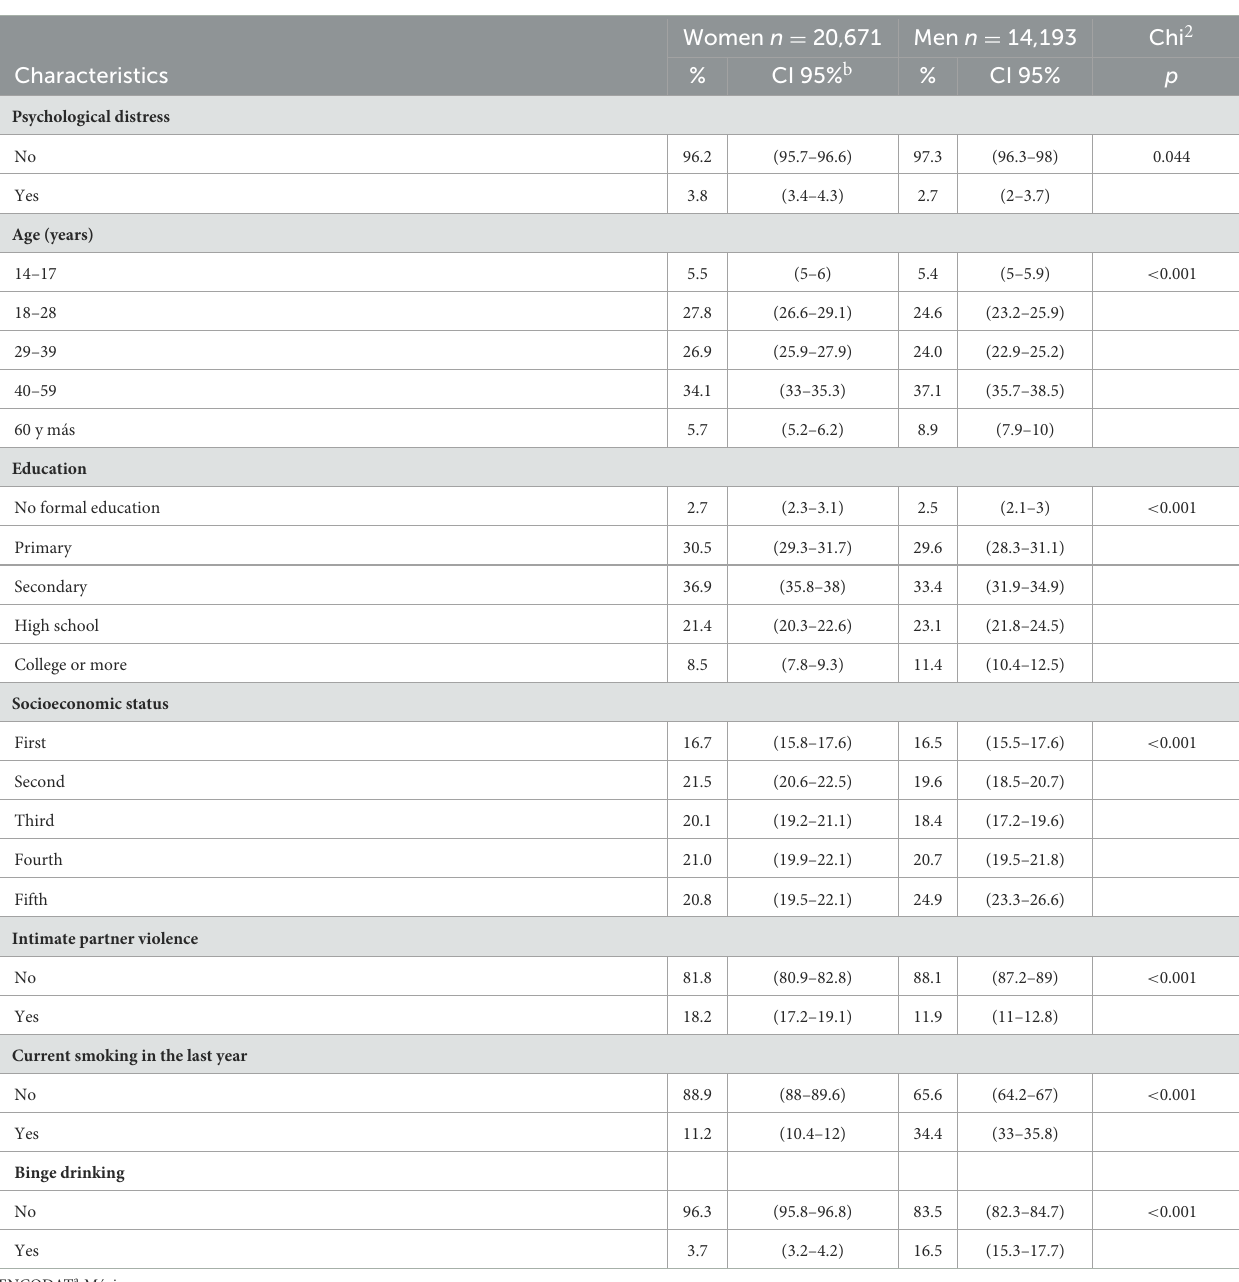
TABLE 1 Study population